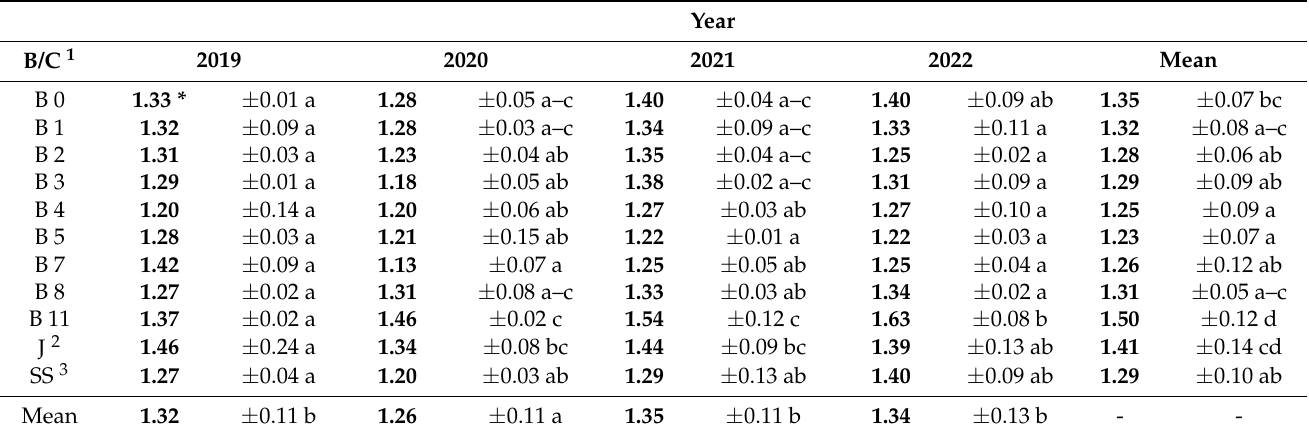
Table 8. Fruit length to width ratio of Elaeagnus multiflora biotypes and cultivars.